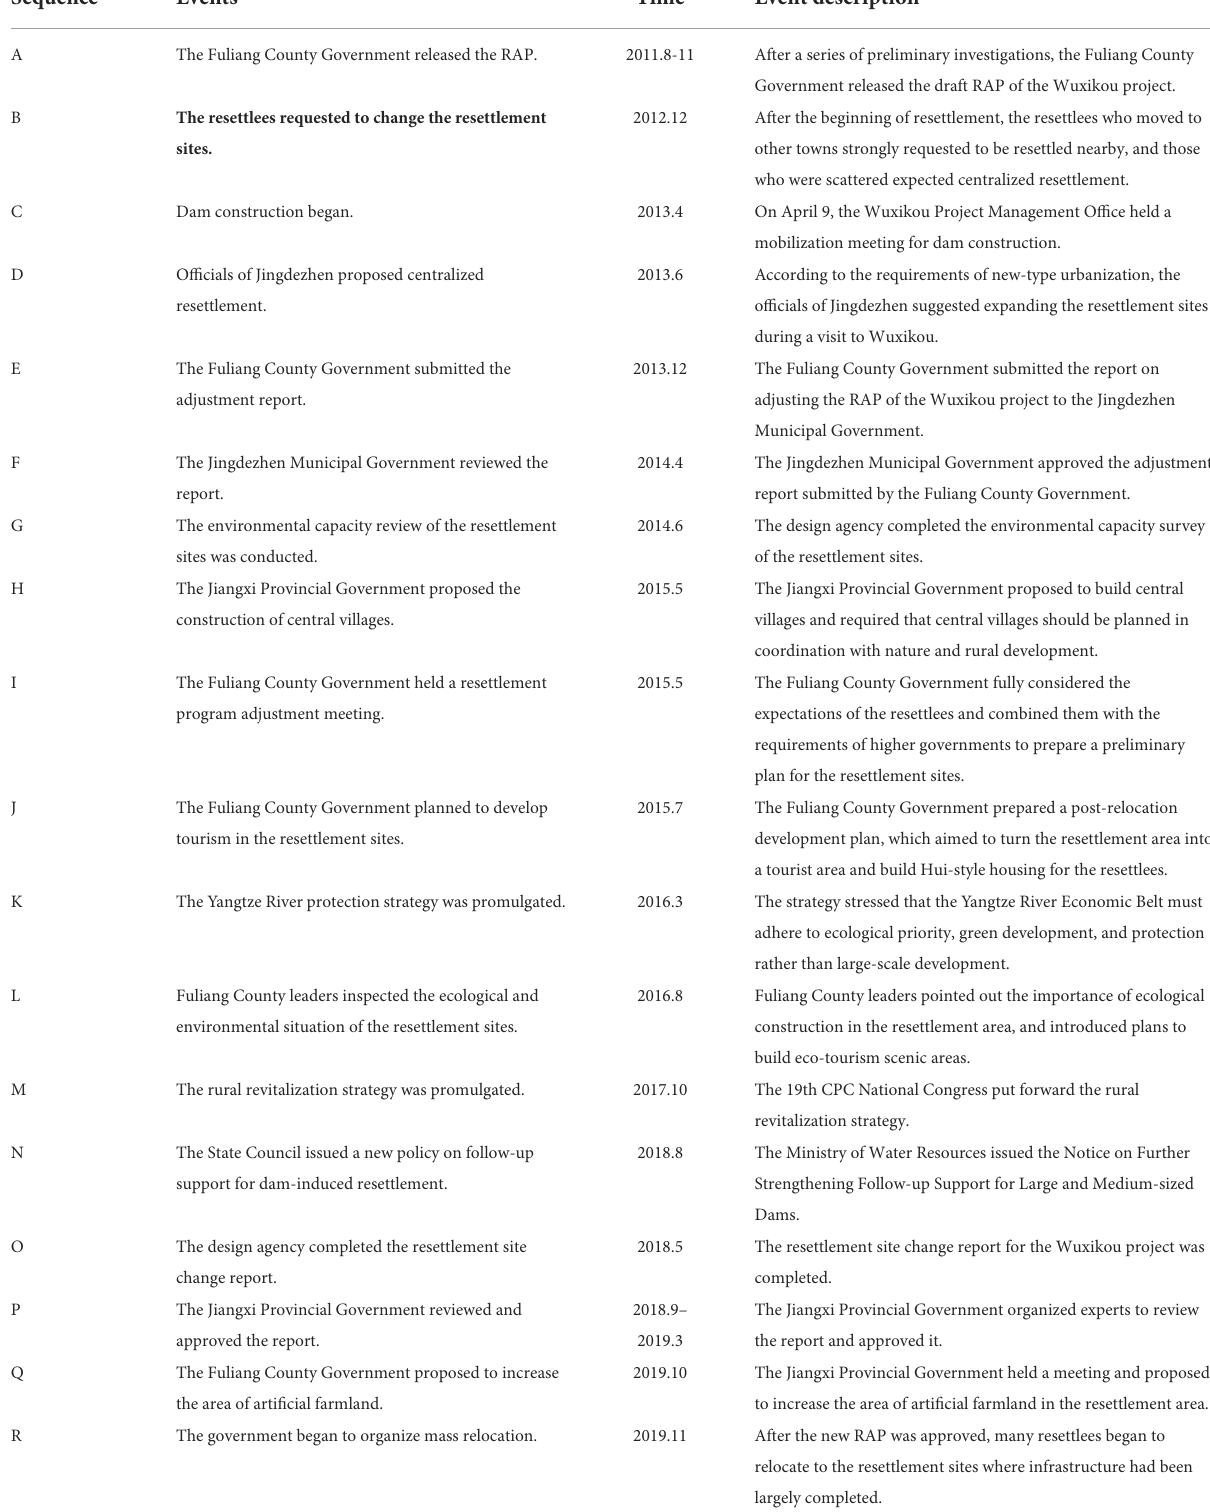
TABLE 6 Events overview and their basic attributes